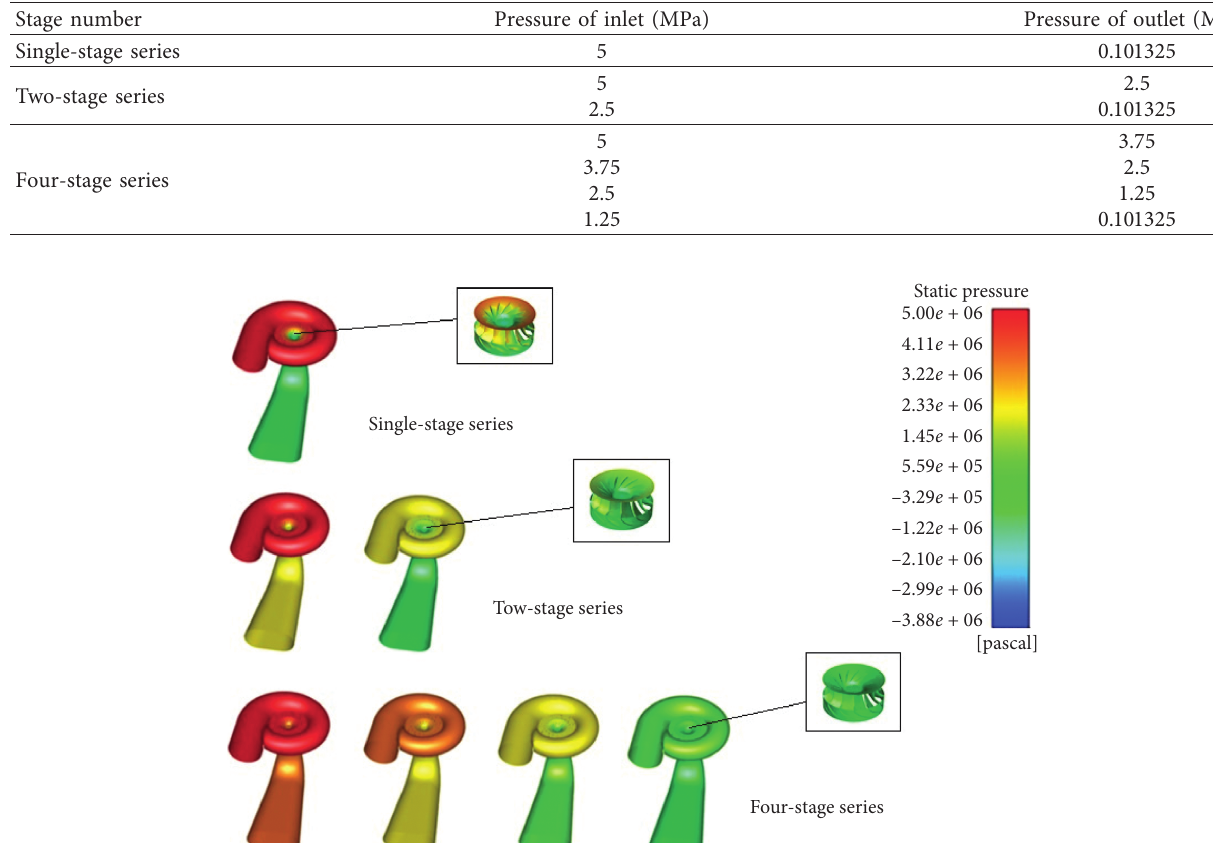
Figure 8: Pressure distribution of different series modes of large-size hydraulic